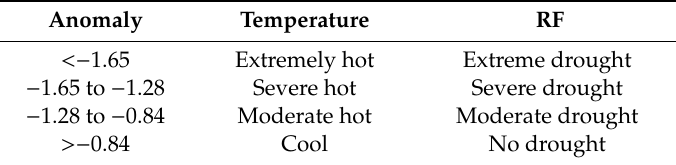
Table 4. Drought severity index based on standard rainfall anomalies